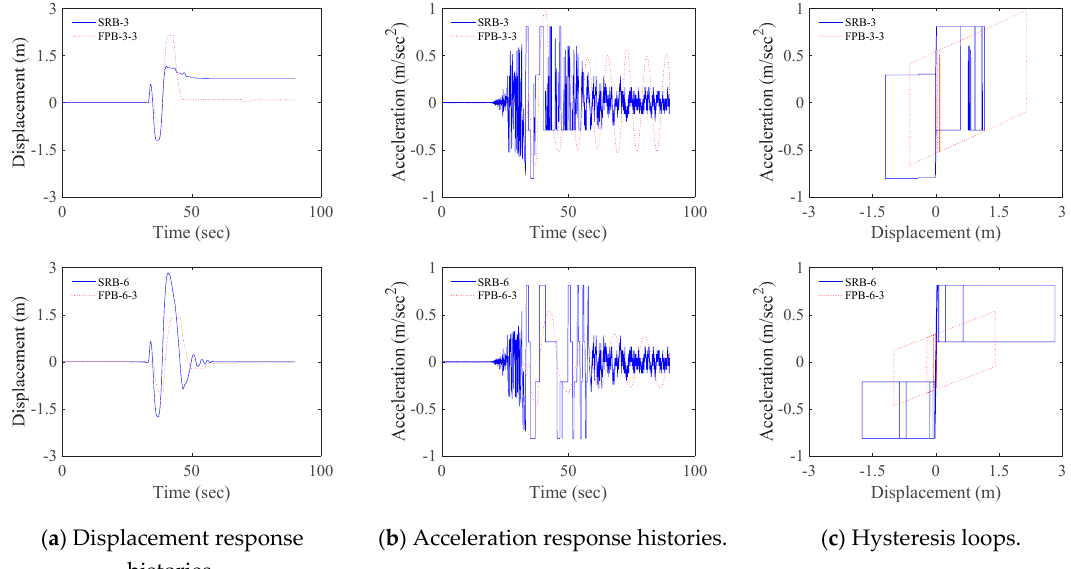
Figure 16. Numerical results of SRB-3, FPB-3-3, SRB-6, and FPB-6-3 under 1999 Taiwan Chi-Chi, TCU052 (EW) (Group 3).